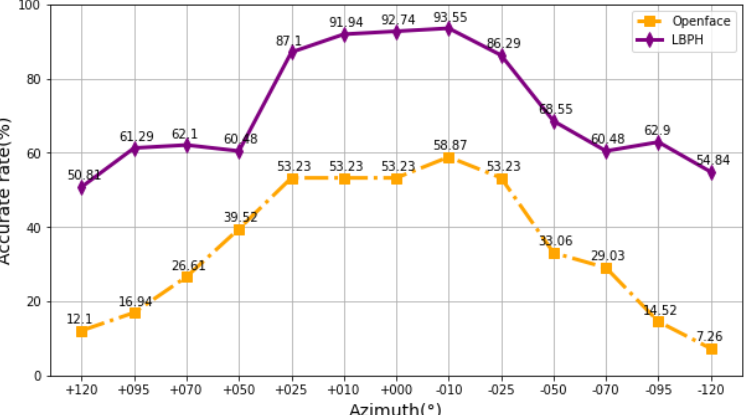
Figure 12. Average ambient lighting accuracy rates of A+120--120E+00 group. ∑ 31 (( Number of sheets with identification errors ÷ 4 ) × 100% ) ÷ 31 (4) Error rate = 1